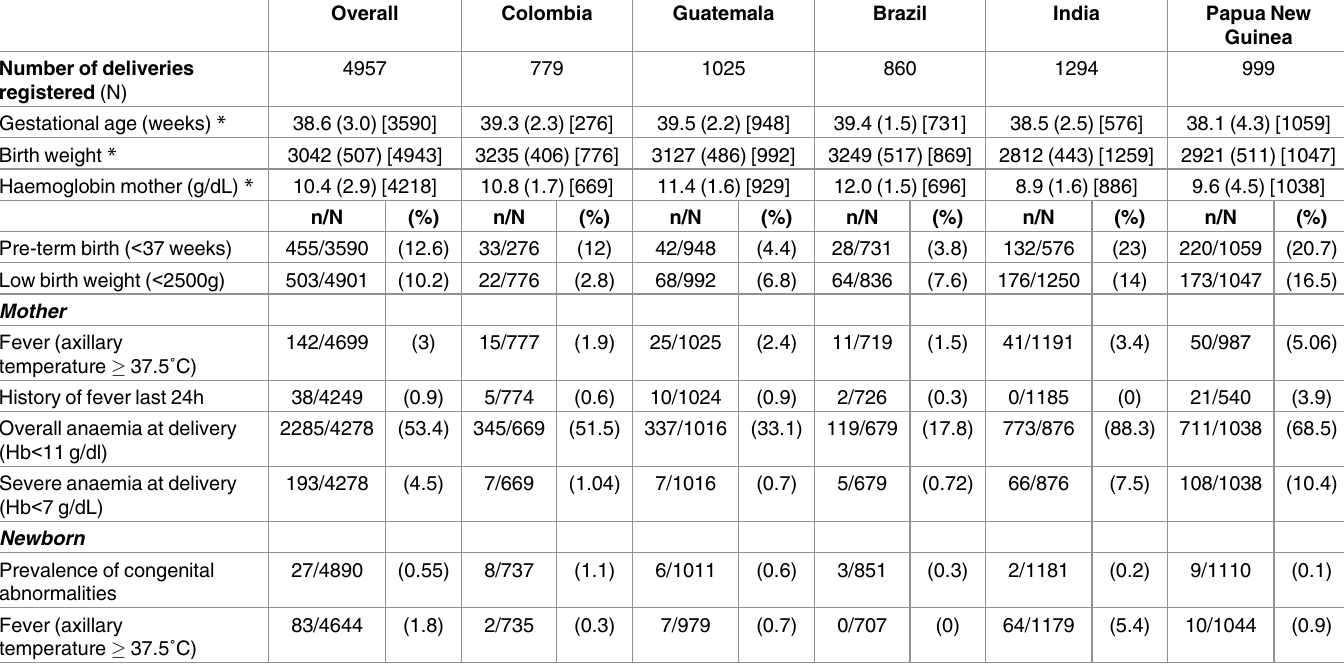
Table 6. Pregnancy outcomes.